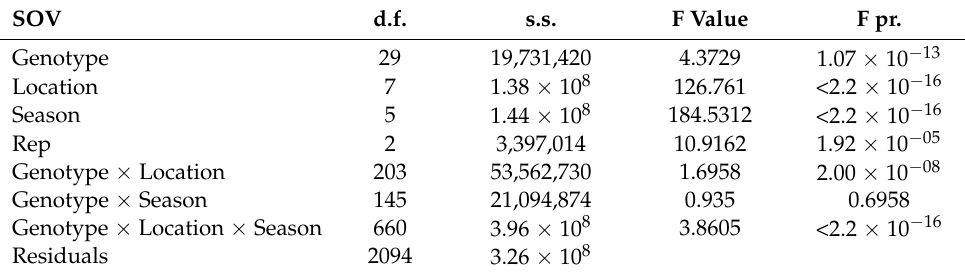
Figure 5. QQ plot showing the correlation between the grain yield and normal distribution. Table 5. Analysis of variance of 30 soybean genotypes evaluated for the grain yield in eight locations and six seasons in